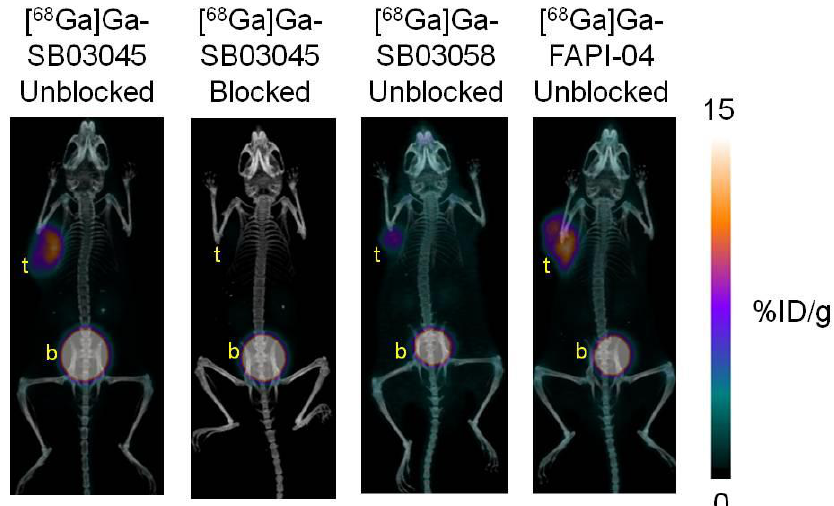
Figure 3. Representative maximum intensity projection PET/CT images of [ 68 Ga]Ga-SB03045 (un- blocked and blocked) and [ 68 Ga]Ga-SB03058 at 1 h pi in HEK293T:hFAP tumor-bearing male NRG mice. The mice in the blocked group were co-injected with nat Ga-FAPI-4 (0.5 mg/mouse). The image of [ 68 Ga]Ga-FAPI-04 has been reported previously [30] and is displayed here for comparison. t: tumor; b: urinary bladder.